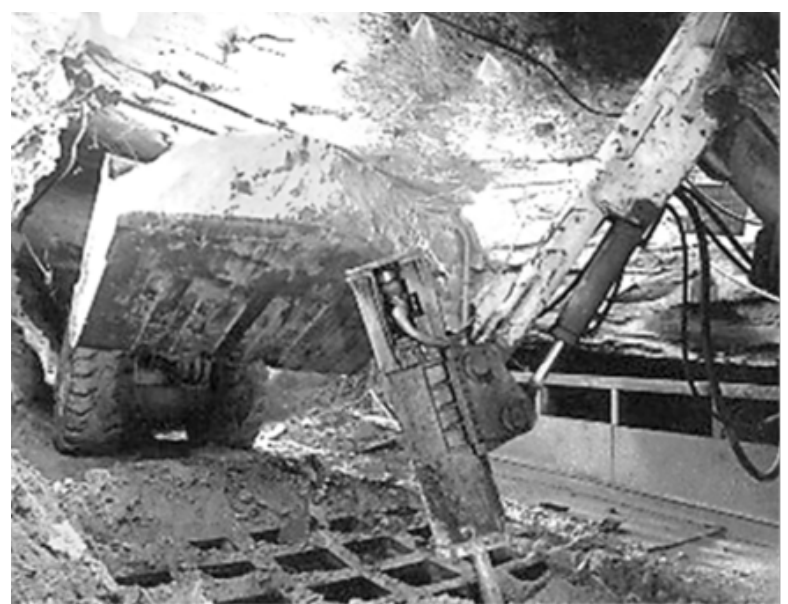
Figure 11. The dumping point with a screen and hydraulic hammer on the manipulator in the underground mine (Stefaniak et al. [87]).